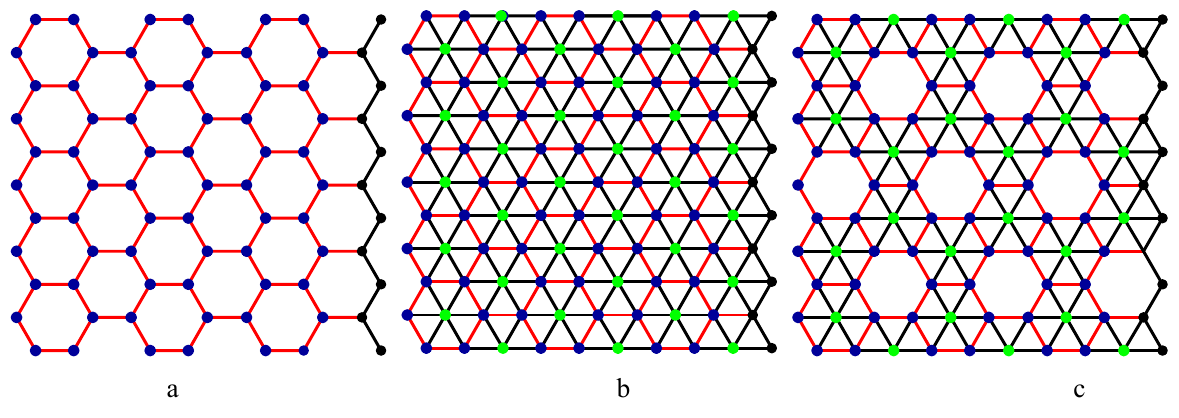
Figure 1. a. Carbon hexagonal sheet (1991); b. Boron triangular sheet (2004); c. Boron α -sheet (2008).